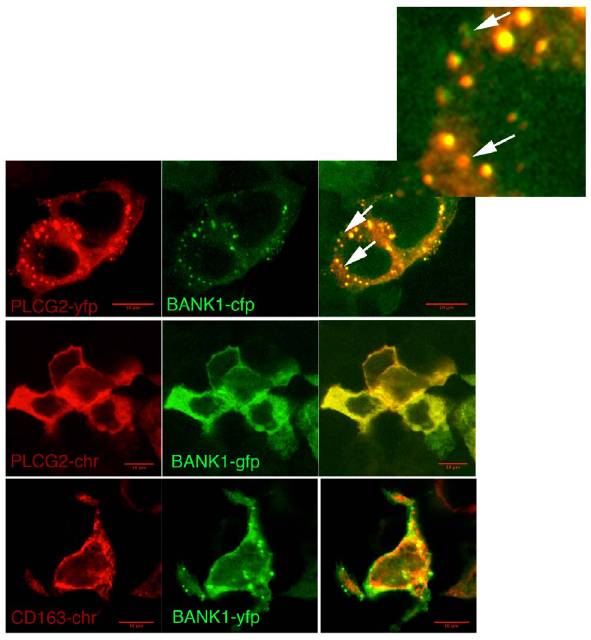
Figure 2. BANK1 and PLCG2 co-localize in cytoplasmic compartments. Confocal images of HEK293 cells co-expressing fluorescently tagged proteins. BANK1 is a cytoplasmic adaptor protein that shows a punctate and homogeneous pattern of distribution. PLCg2 shares the same sub-cellular compartments when co-expressed with BANK1. Upper row, co-expression of PLCg2 and BANK1 showing sub- cellular co-localization in punctate structures. Although a perfect co- localization between the two proteins is observed, there are dots (indicated by arrows, both in the merge image and in the amplification at the right upper corner) in which the ratio of the two proteins is reversed. Cross-talks between light channels were further ruled out by assessing the emission on cells expressing only one fluoresce protein and excitated sequencially with both lasers. Middle row, images showing co-localization between PLCg2 and BANK1 in a homogeneous cytoplasmic distribution. Lower row, images showing only partial co- localization between the cytoplasmic scavenger receptor, CD163 and BANK1. Scale bar: 10 m m.(-yfp; yellow fluorescence protein. –cfp; cyan fluorescence protein. –chr; cherry fluorescent protein. –gfp; green fluorescent protein).